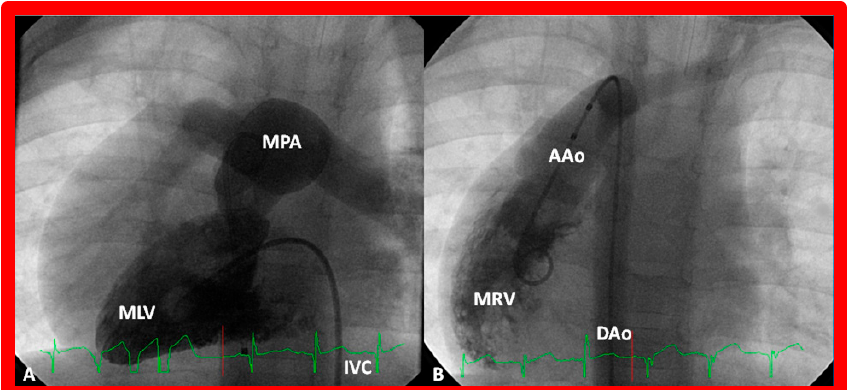
Figure 36. ( A ) Cine frame from morphologic left ventricular (MLV) cineangiogram in a posteroanterior view of an infant with dextrocardia, exhibiting fine trabeculations of the MLV on the left side. The MLV gives origin to the main pulmonary artery (MPA), which is dilated. The position of the catheter in the inferior vena cava (IVC) is on the left side of the spine. ( B ) Demonstrates a morphologic right ventricle (MRV) in a posteroanterior view in the infant shown in ( A ); coarse trabeculations are seen. The right-sided MRV gives rise to the aorta, denoted by AAo. The aorta descends on the right side of the spine. The aortic valve is situated rightward and superior to the pulmonary valve. It is located anteriorly in the lateral view (not shown). This information suggests a d-loop of the ventricles and d-transposition of the great arteries in a subject with dextrocardia, a disorder suggestive of corrected transposition physiology. DAo, descending aorta. Replicated from reference [36].